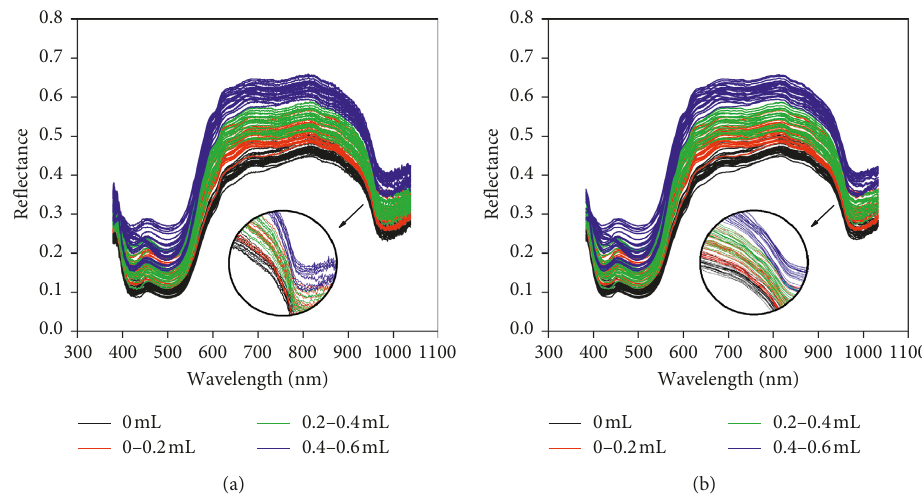
Figure 1: Averaged spectral profiles of salmon samples with (a) different water amounts injected and (b) different water amounts injected after SG smoothing.